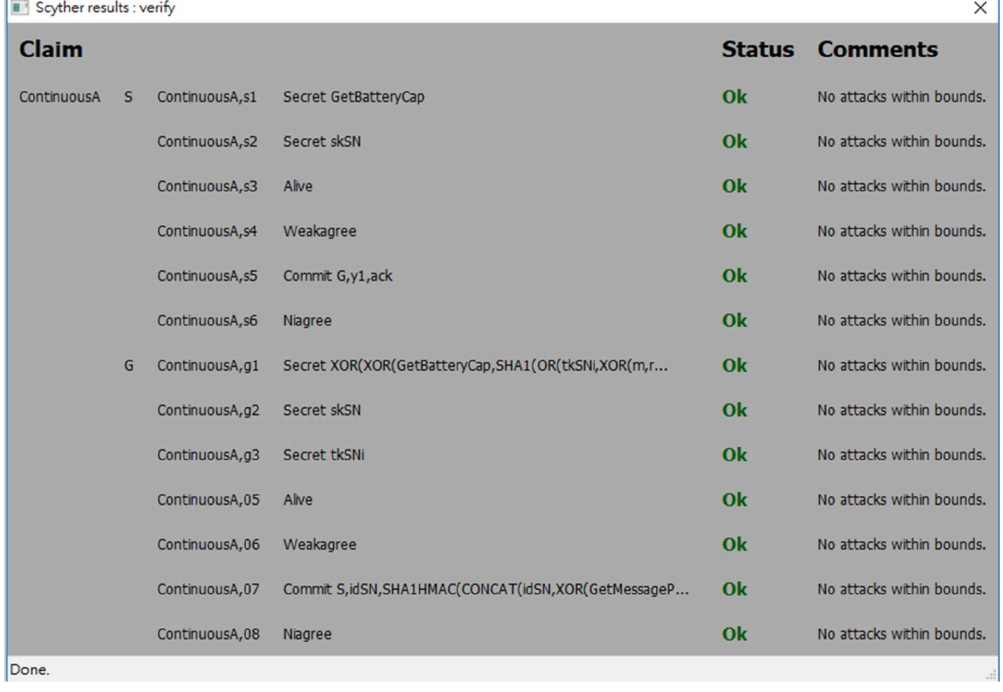
Figure 10. The security analysis result of the continuous authentication phase in Condition